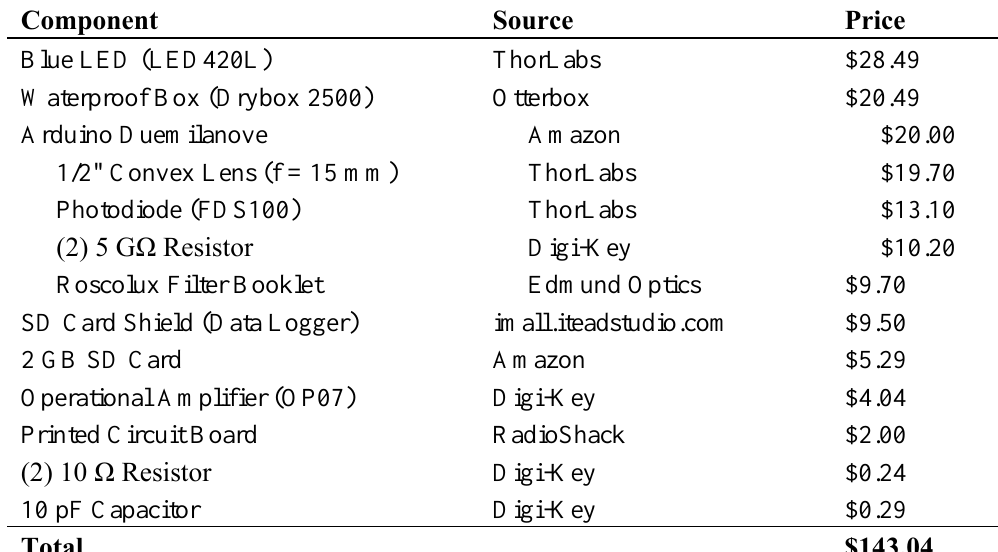
Table 1 . List of prices (in US dollars) and sources for all components in the